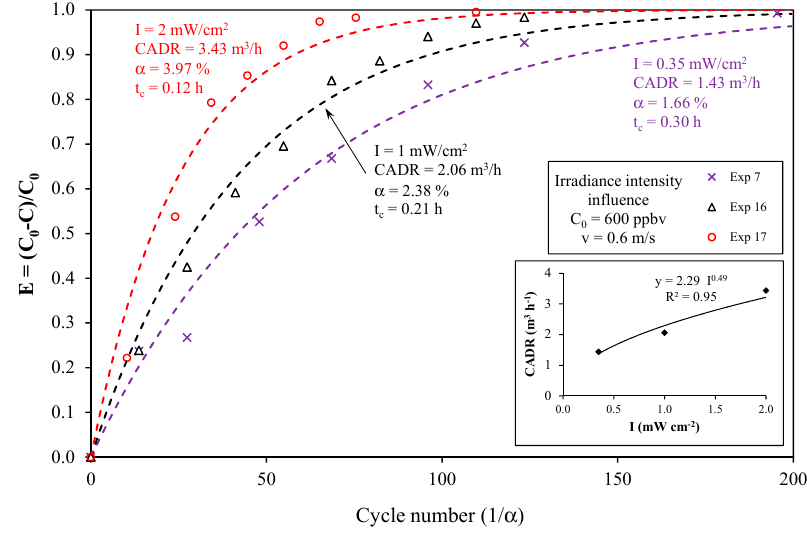
Figure 6. Effect of irradiance intensity on toluene removal efficiency (experimental points and model). Insert: effect of irradiance intensity on the CADR value.